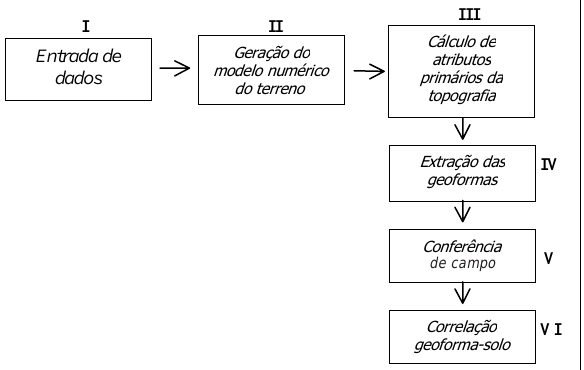
Figura 3. Diagrama de fluxo das atividades